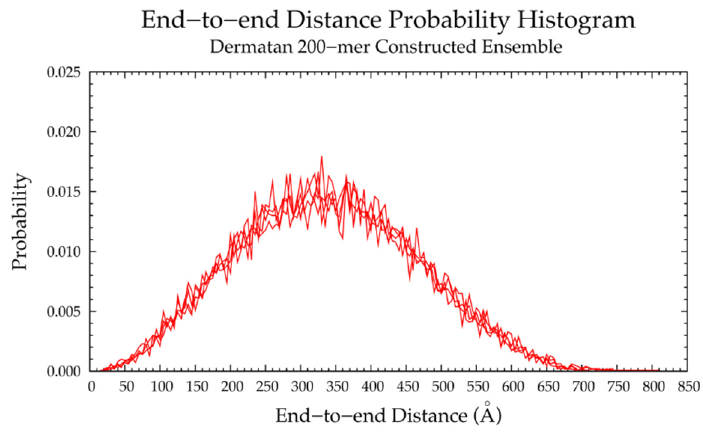
Figure 13. End-to-end distance probability distribution of constructed ensemble of nonsulfated dermatan200-mer; most probable end-to-end distance across all four sets is 365 Å; probabilities were calculated for end-to-end distances sorted into 5 Å bins; the ensemble contains four sets of 10,000 conformations.